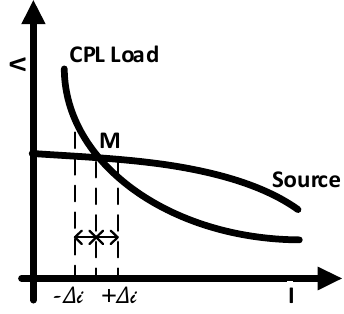
Figure 1. Negative impedance characteristic of constant power load.